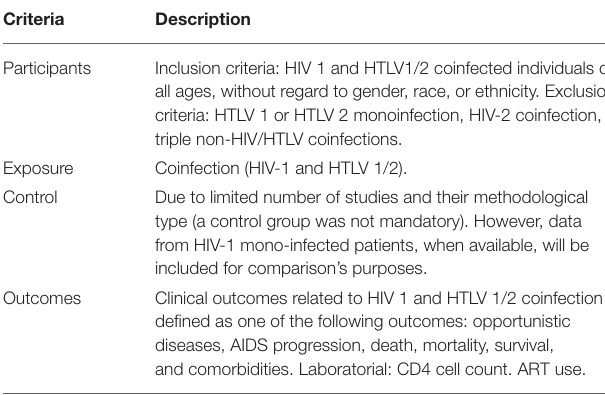
TABLE 1 | The PECO criteria used in the study. Criteria